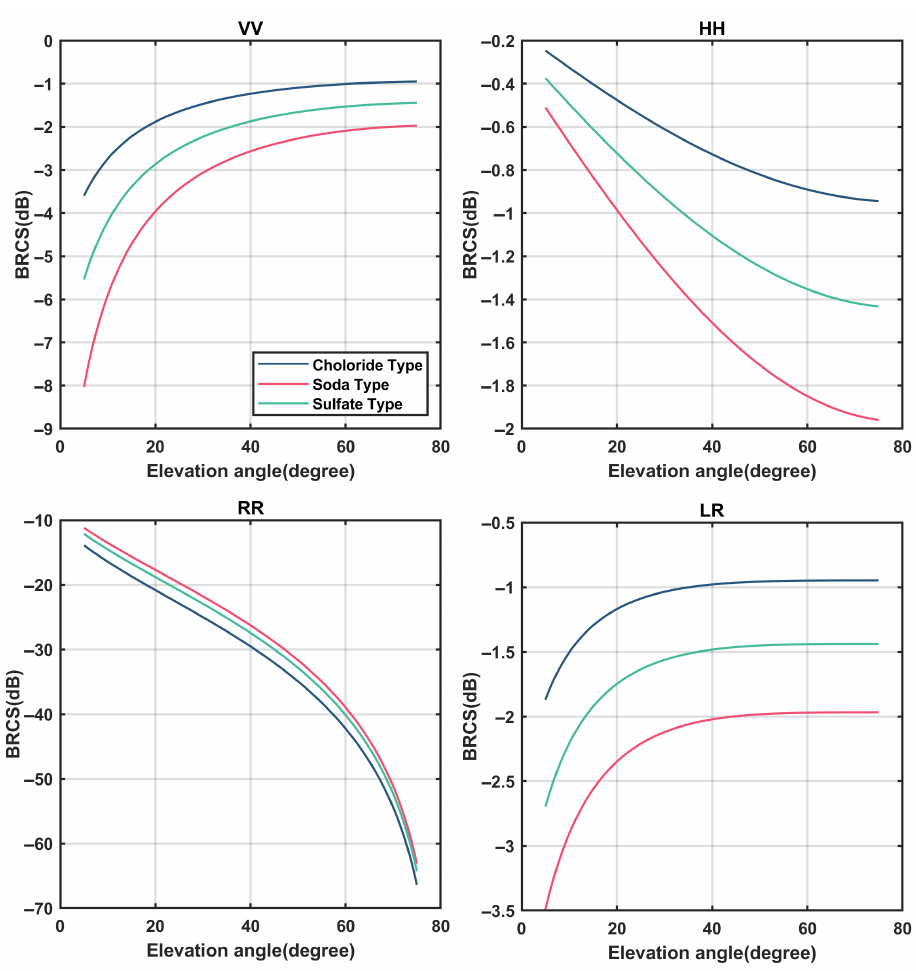
Figure 7. Variation of BRCS with elevation angle for three soil solutions with different polarizations (VV, HH, RR, and